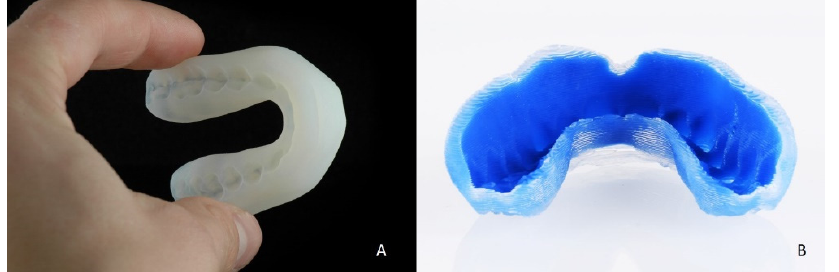
Figure 6. ( A ) The Polyjet printed soft multilayer MG. ( B ) The ACEO silicone printed soft multilayer MG.